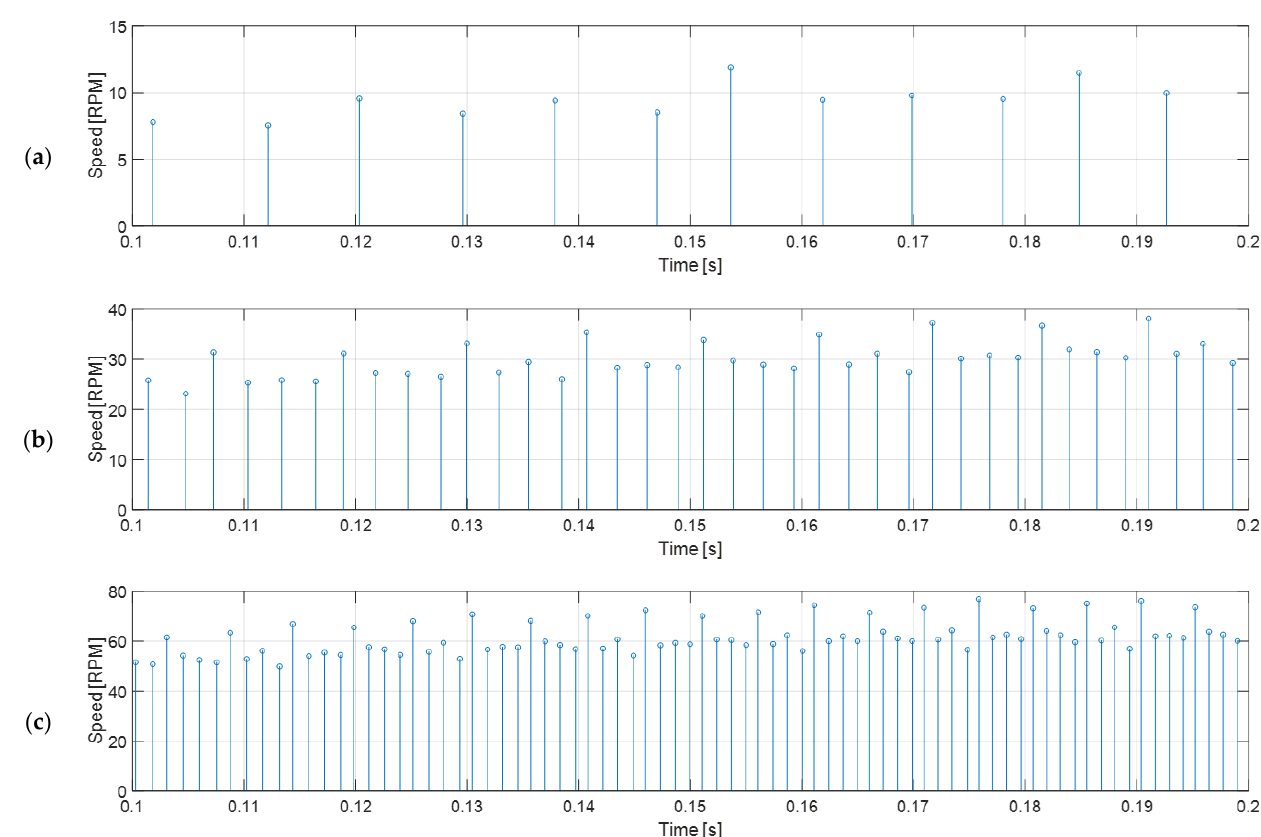
Figure 7. Open-loop wheel speed measurement deduced from the raw time-elapsed edge measurements gathered from the magnetic encoder of the BDCM for the different PWM duty cycles applied: ( a ) 20% or low-speed example; ( b ) 50% or medium-speed example; ( c ) 100% or full-speed example.